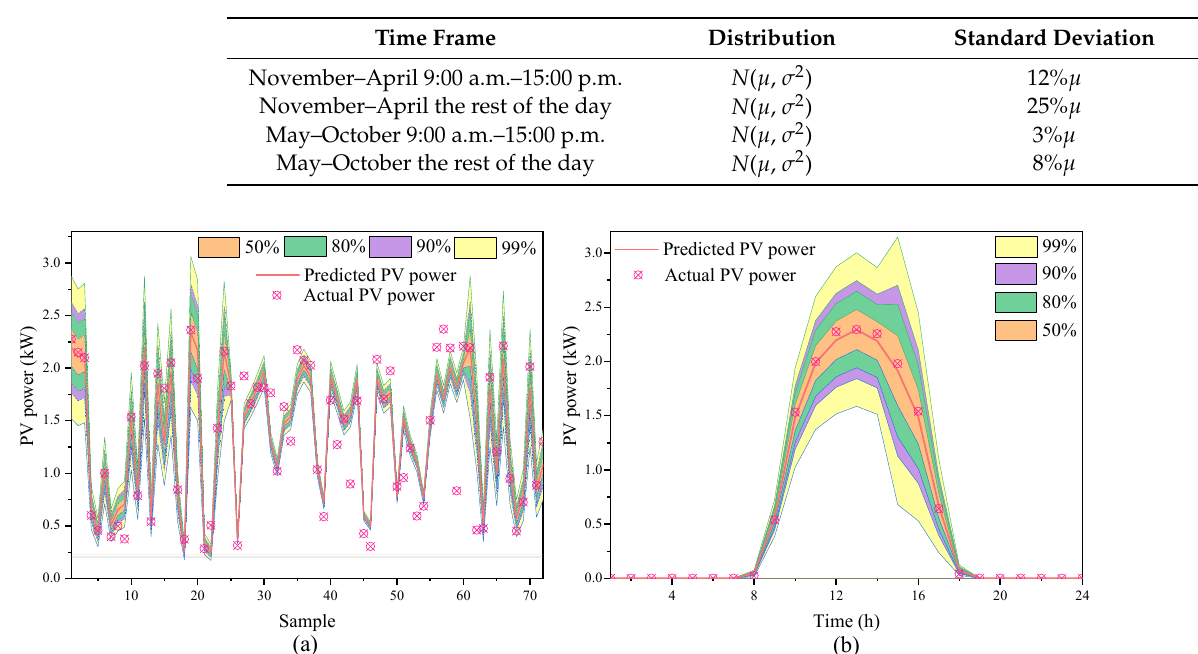
Figure 14. Actual and predicted PV power of various forecasting models for various seasons. ( a ) Probabilistic forecasting results for time period of 11–12 o’clock; ( b ) probabilistic forecasting results of a typical day.